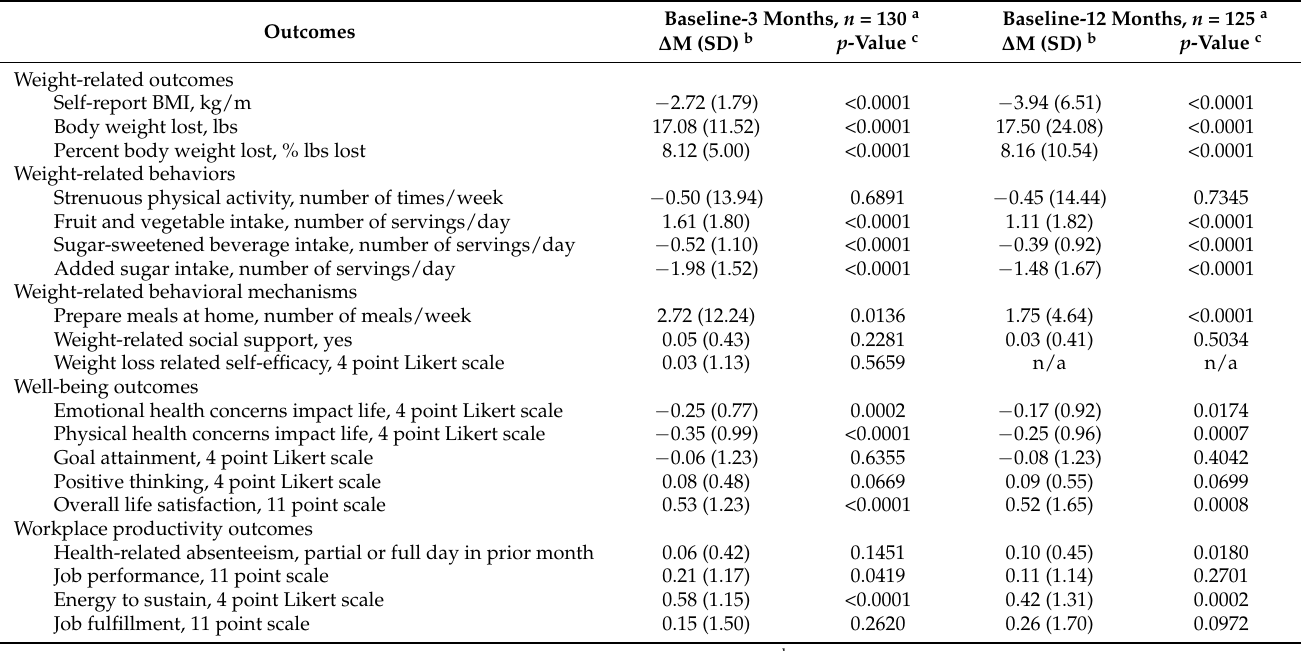
Table 2. Change in participant’s survey-measured weight-related, workplace and well-being outcomes at 3 and 12 months.